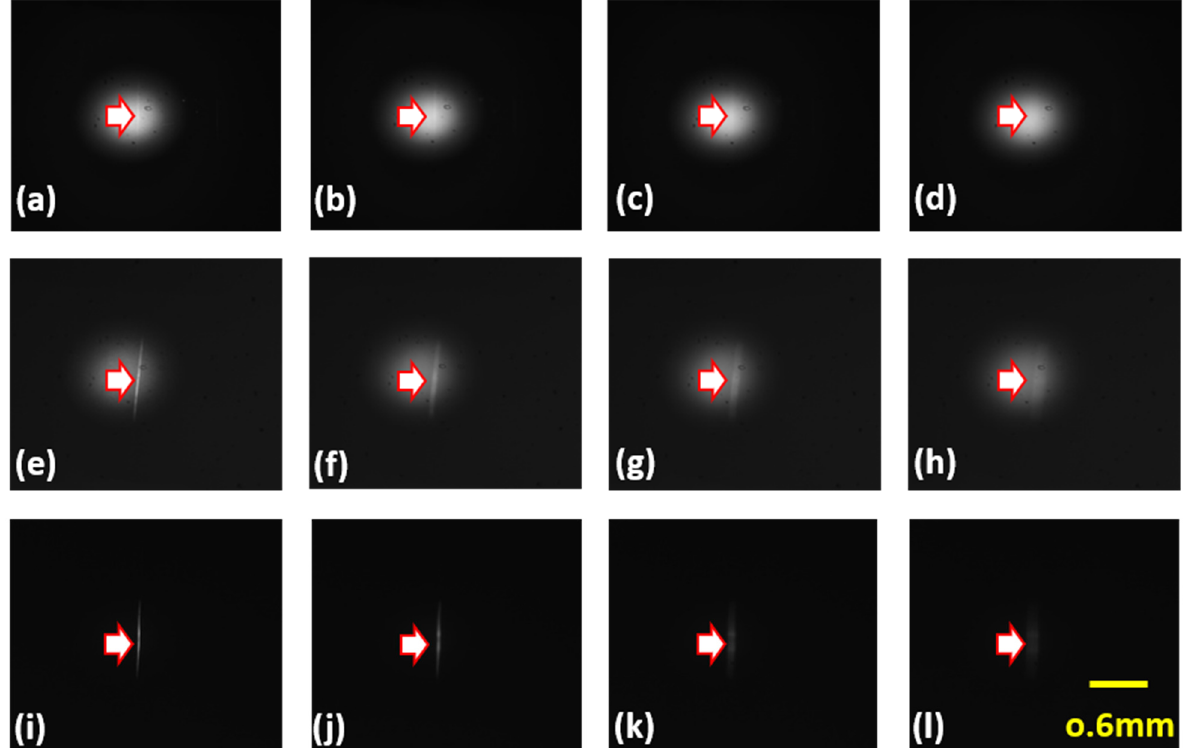
Figure 4. The target images taken from the WIS system with normal direction of the sample tilting 7° from the incident angle. The paint on the back surface of the glass was ( a – d ) white, ( e – h ) gray, and ( i – l ) black. ( a , e , i ) in the first column show the pictures in focus; ( b , f , j ) in the second column show the pictures defocusing 1mm; ( c , g , k ) in the third column show the pictures defocusing 2 mm; ( d , h , l ) in the third column show the pictures defocusing 3 mm.